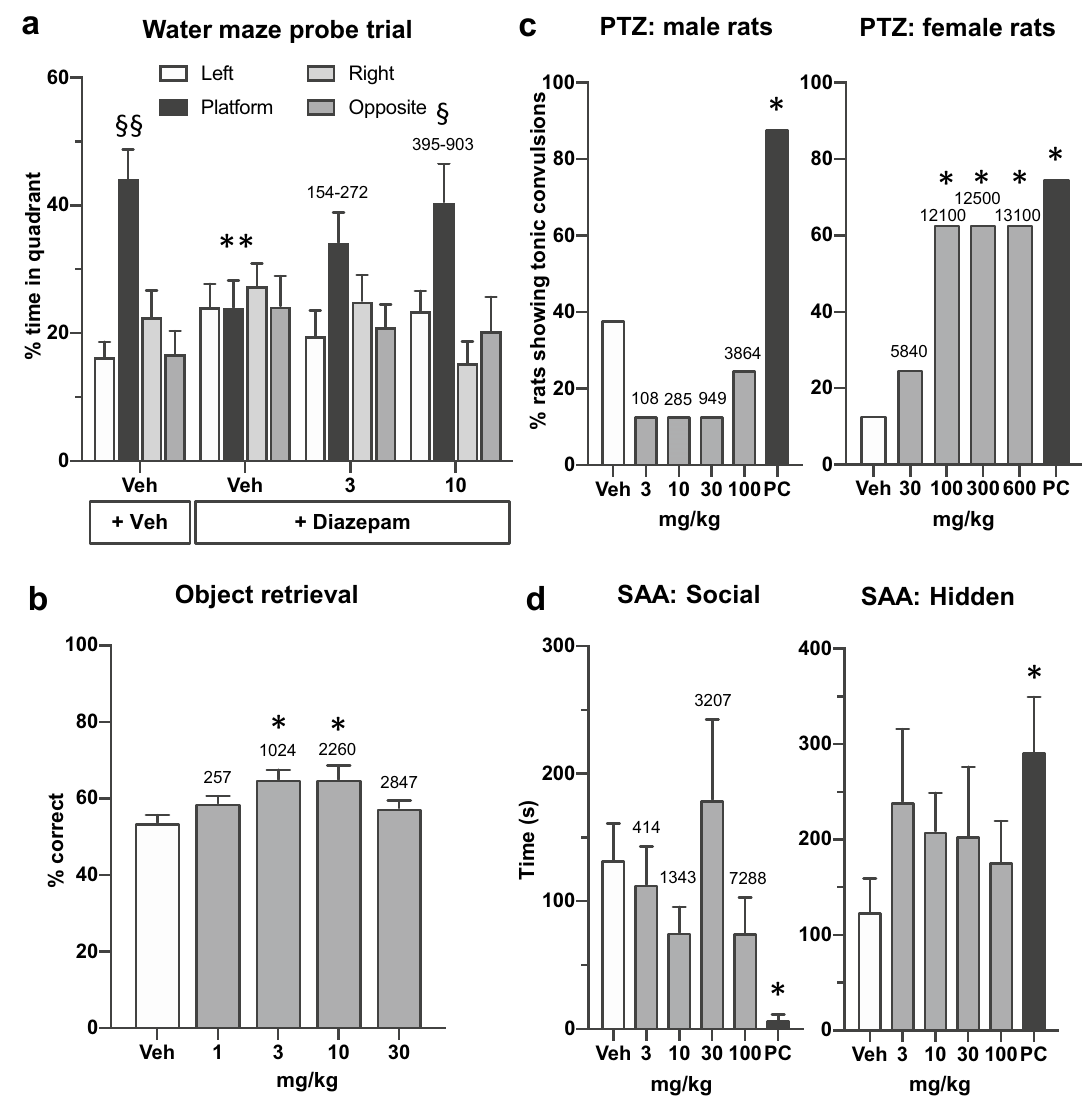
Figure 4. Basmisanil improved cognition in rodents and non-human primates at plasma concentrations which did not show anxiogenic or proconvulsant effects. ( a ) Basmisanil reversed the diazepam-induced spatial learning impairment of rats in the Morris water maze. Basmisanil (3 and 10 mg/kg p.o. as indicated below the abscissa) and diazepam (6 mg/kg i.p.) were administered to male Lister Hooded rats 30 min before the test. Data are presented as mean ± SEM (n = 10 per dose group). Statistics: *Significant difference between vehicle and diazepam-treated groups on percent time in platform quadrant (unpaired t-test); § significant difference between percent time spent in platform quadrant versus left, right and opposite quadrants (post hoc Newman- Keuls test). Total plasma concentrations (ng/mL) for each dose are shown above each bar and were collected in parallel to the experiment (n = 4 per dose). The range shows the concentrations at 30 and 100 min post- administration which are equivalent to the beginning and end of testing. ( b ) Basmisanil improved executive function in adult cynomolgus macaques. The effect of basmisanil administered at 1, 3, 10 and 30 mg/kg p.o. on percent correct (first reaches) during difficult trials of the object retrieval task. Data are presented as mean ± SEM (n = 12/dose; within-subjects design). Statistics: *Significant difference versus vehicle-treated group (post hoc Dunnett’s test). Total plasma concentrations (ng/mL) for each dose are shown above each bar. Samples were collected at 180 min for the same three subjects. ( c ) Effect of basmisanil and the positive control (PC), FG7142, on the percent of male or female rats with tonic convulsions following administration of a threshold dose of PTZ (n = 8 per treatment group). *Significant difference versus vehicle group (Pearson Chi-Square test). Plasma samples were collected either immediately following tonic convulsions or 30 min following PTZ, i.e., approximately 60–90 min (males) or 180–210 min (females) post administration of basmisanil (n = 8 per dose). ( d ) Effect of basmisanil administered p.o. 1 h prior to testing and the positive control (PC), Ro 19-4603 administered p.o. 30 min prior to testing, in the social approach avoidance test in male F-344 rats (n = 10 per treatment group). Data are expressed as mean ± SEM. *Significant difference versus vehicle group (unpaired t-test). Total plasma concentrations (ng/mL) for each dose are shown above each bar. Plasma samples were collected immediately after testing i.e., approximately 75 min post administration of basmisanil (n = 4 per